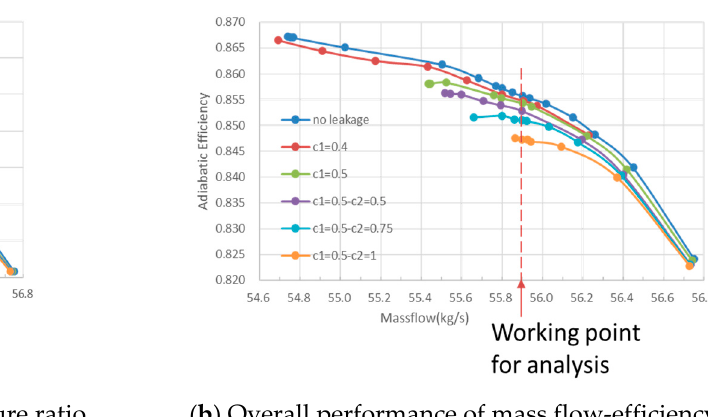
Figure 9. Overall performance of the compressor.